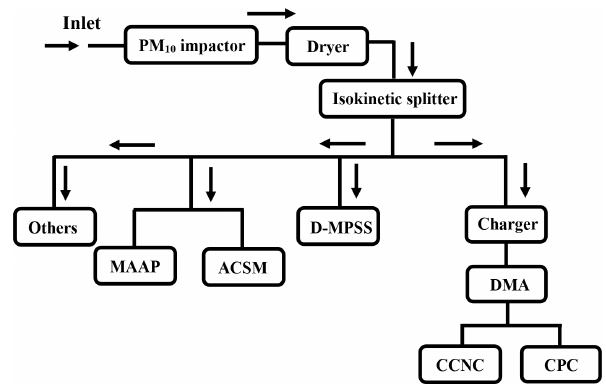
Figure 1. Schematic diagram of the experimental setup. D-MPSS – dual-mobility particle size spectrometer; ACSM – aerosol chem- ical species monitor; MAAP – multi-angle absorption photometer; DMA – differential mobility analyzer; CPC – condensation particle counter; CCNC – cloud condensation nuclei